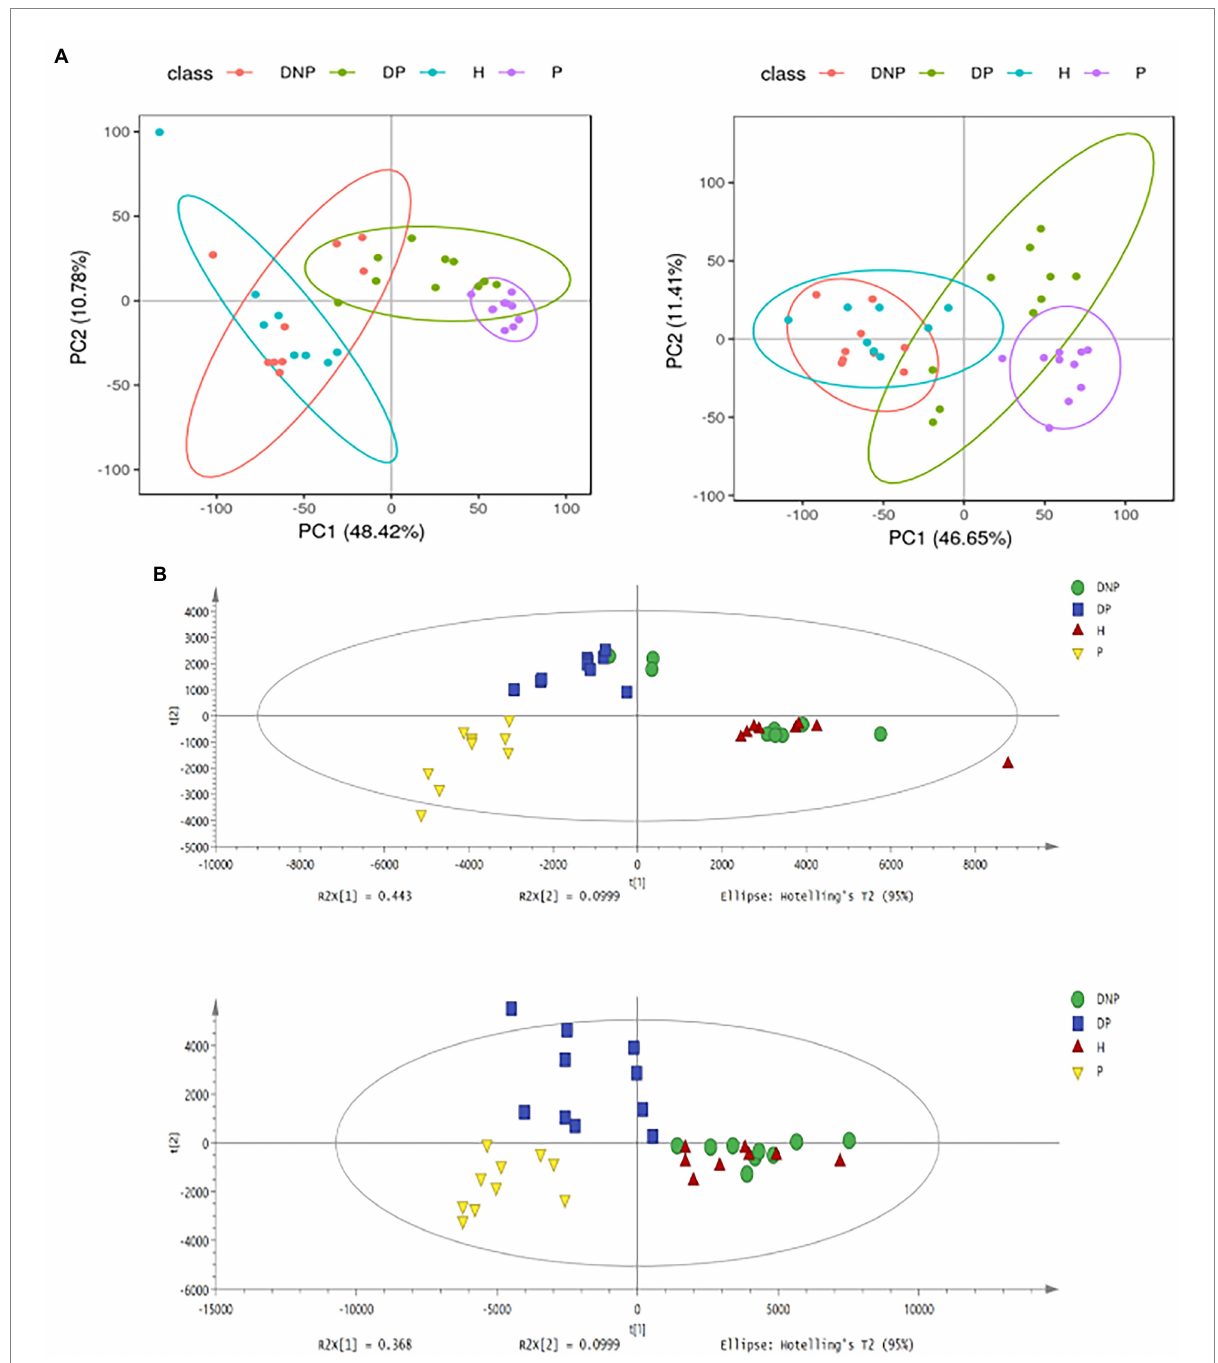
FIGURE 8 PCA and PLS-DA score plots of plasma samples among groups. (A) PCA score plots in ESI+ model (left panel) or ESI– model (right panel); (B) PLS- DA shows a significant difference among groups with satisfactory accuracy and prediction (pos R2X: 0.467, R2Y: 0.518, Q2: 0.403; neg R2X: 0.543, R2Y: 0.495, Q2: